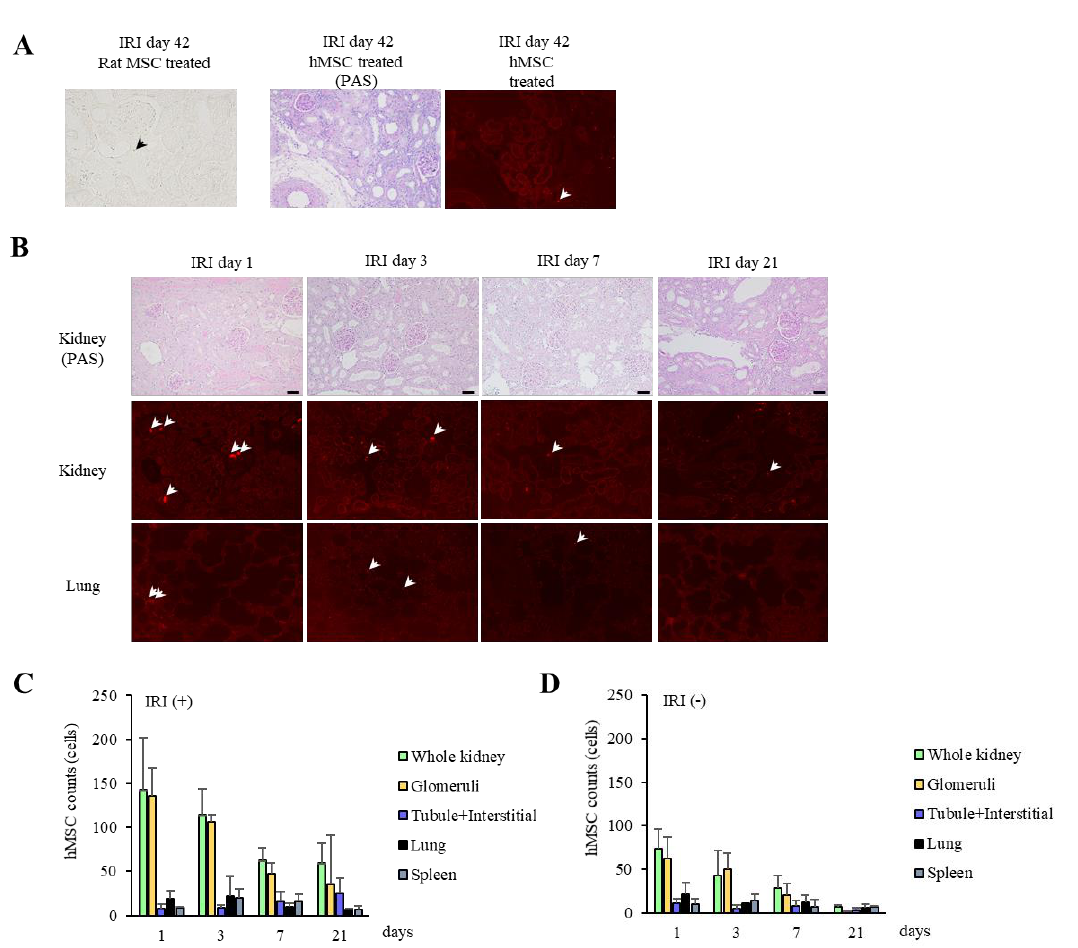
Figure 4. Time course of engraftment of hMSCs after IRI. ( A ) Both rat MSCs (black arrow) and hMSCs (white arrows) were sparsely observed at day 42 post-IRI. ( B ) Localization of arterial delivered CM-DiI-stained hMSCs (5 × 10 5 hMSCs/rat, red-labeled cells; arrows) in kidney and lung tissue sections. PAS stain photos clarify the structure of kidney sections with images showing CM-DiI-stained hMSCs (middle). CM-DiI-stained hMSCs appeared mostly in glomeruli at day 1 post-IRI and were gradually detected in tubular walls and the interstitium ( × 100, scale bar = 50 µ m). ( C , D ) The number of CM-DiI-stained hMSCs delivered arterially in 10 random fields (×100) in kidney, lung, and spleen at days 1, 3, 7, and 21 post-IRI, and without undergoing IRI. When hMSCs were injected intra-arterially, most engrafted hMSCs were found in the kidney. Abbreviations: hMSCs, human mesenchymal stem cells; IRI, ischemia-reperfusion injury; PAS, periodic acid-Schiff.